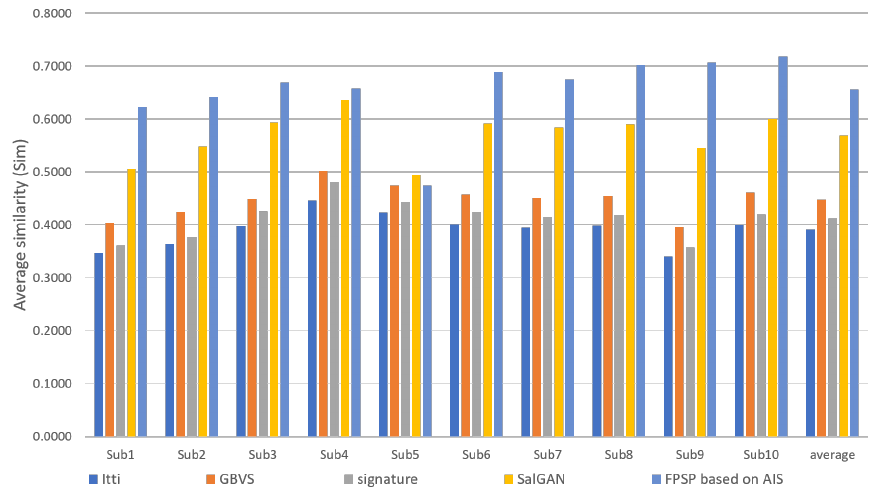
Figure 7. Average similarity (Sim) of each target person ( ↑ ) with comparison to USM prediction methods.